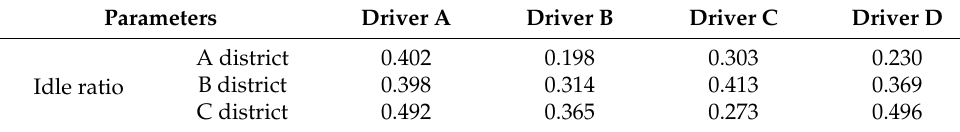
Table 7. Idle ratio from different drivers.